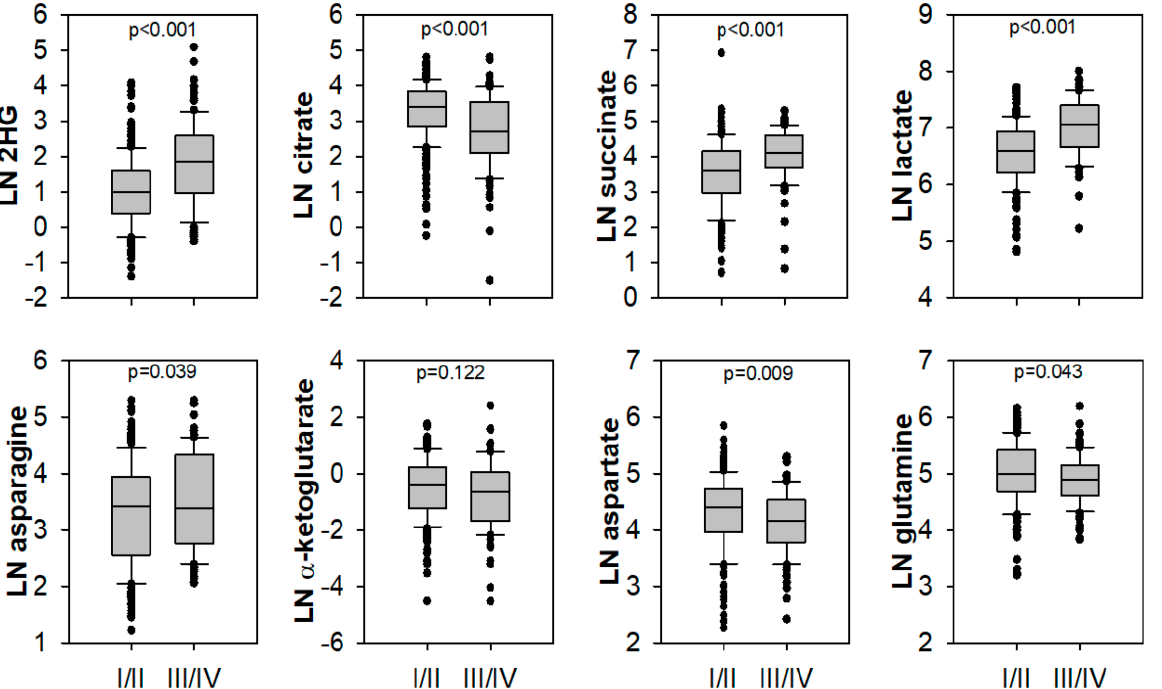
Figure 2. Significantly different metabolites between lower (I/II) and higher (III/IV) TNM stage RCC were independent of tumour necrosis. Only non-necrotic tumour samples were plotted, and significance was assessed by a Mann–Whitney U test, n = 342 (I/II 249; III/IV 93), except for pyruvate ( n = 323) and lactate ( n = 289).